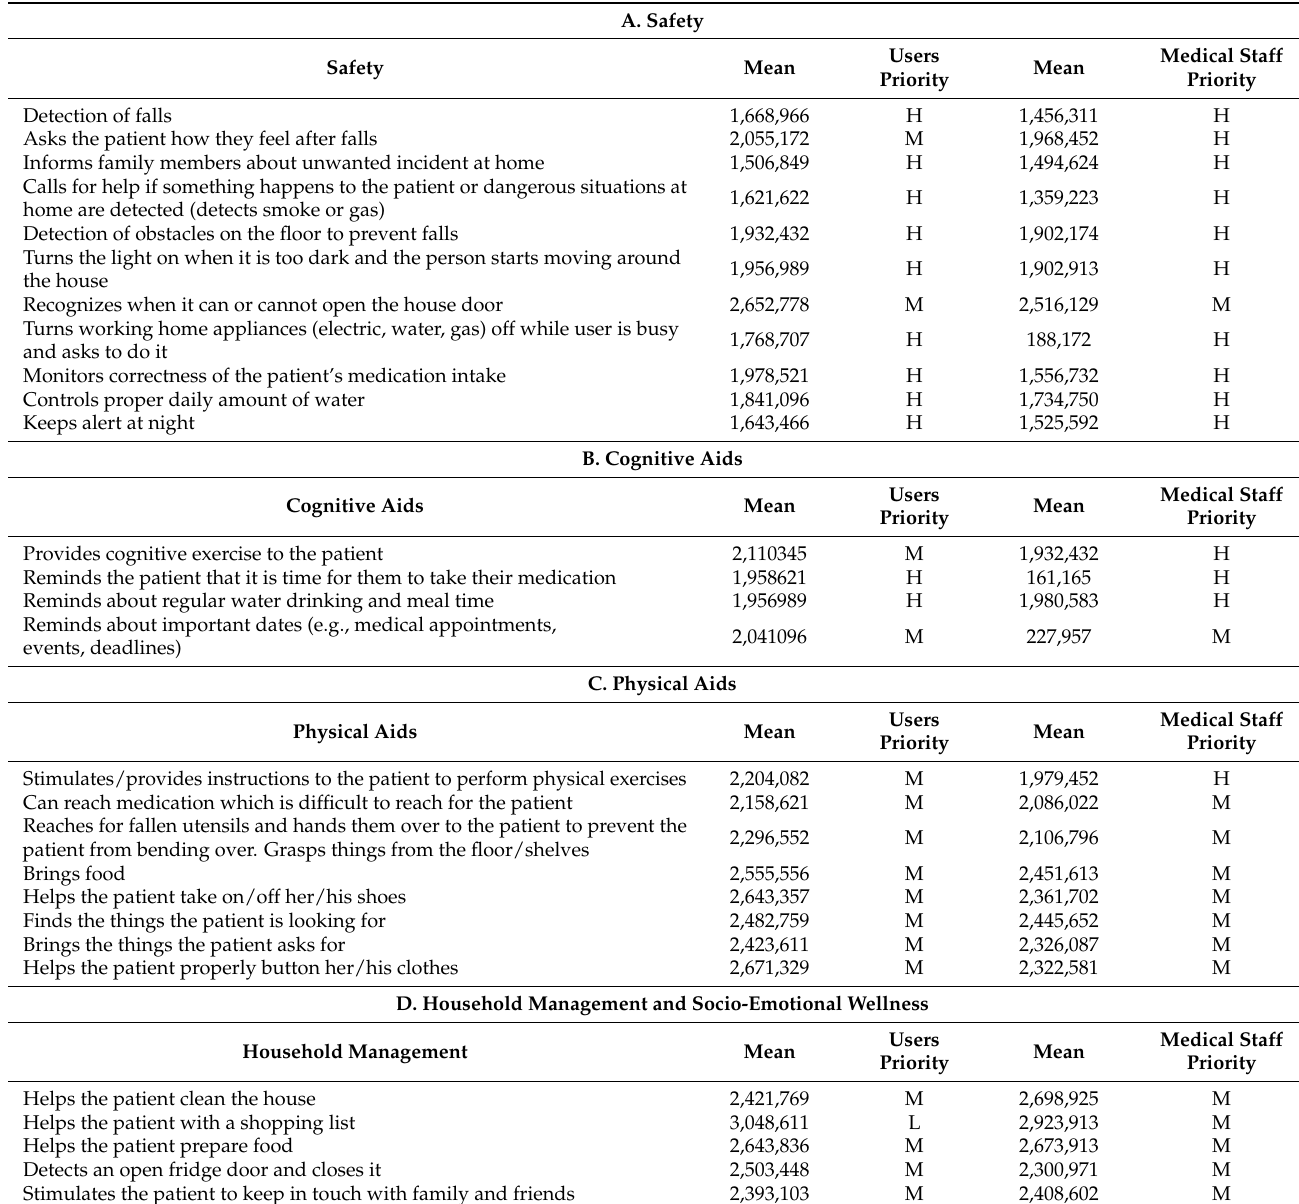
Table 3. Prioritization of target use cases of the robotic